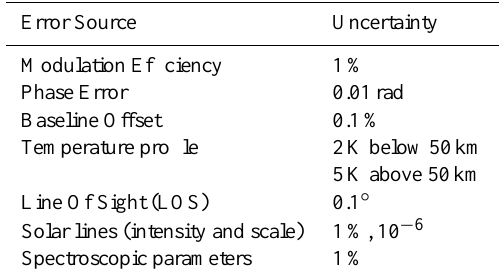
Fig. 3. Time series of total DOFS of retrieved ozone values using the setup C for the whole FTIR time series between 1999 and 2010 (number of data, N , is 1887).